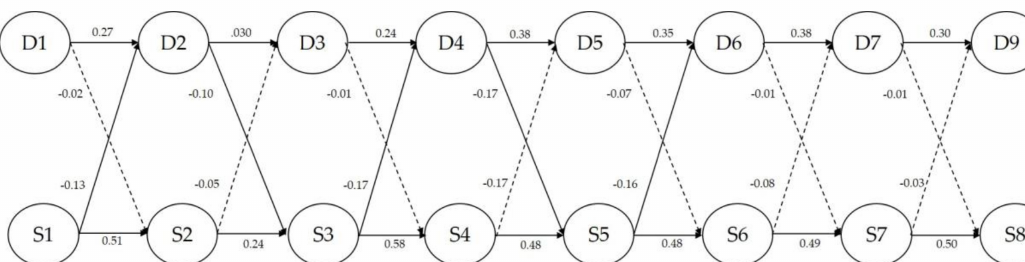
Figure 1. The longitudinal relationship between depression and self-esteem. D1 = Depression 1st, D2 = Depression 2nd, D3 = Depression 3rd, D4 = Depression 4th, D5 = Depression 6th, D7 = Depression 7th, D8 = Depression 8th, S1 = Self-esteem 1st, S2 = Self-esteem 2nd, S3 = Self-esteem 3rd, S4 = Self-esteem 4th, S5 = Self-esteem 6th, S7 = Self-esteem 7th, S8 = Self-esteem 8th, — > Significantly, ····· >